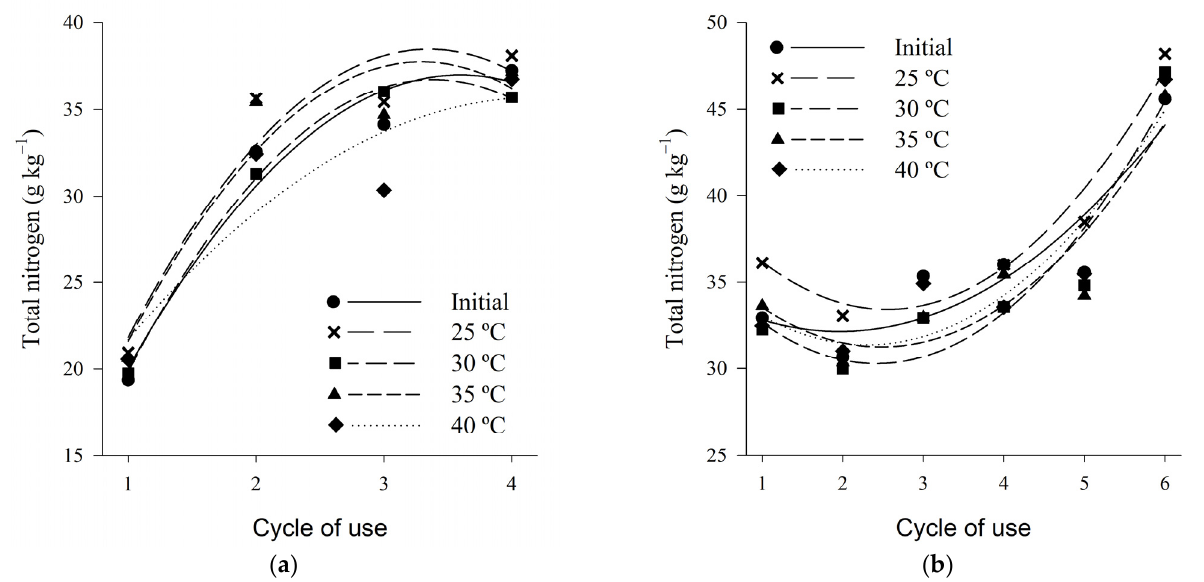
Figure 7. Total nitrogen content of wood shaving bed ( a ) and coffee husk bed ( b ) samples in different cycles of use and heat treatments. Table 3. Equations adjusted for the behavior of total bed nitrogen according to the cycle of